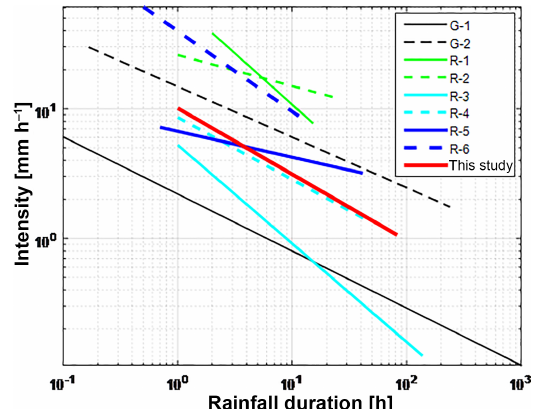
Figure 14. I – D thresholds determined for this study (red line) and those of various other studies. G is global and R is